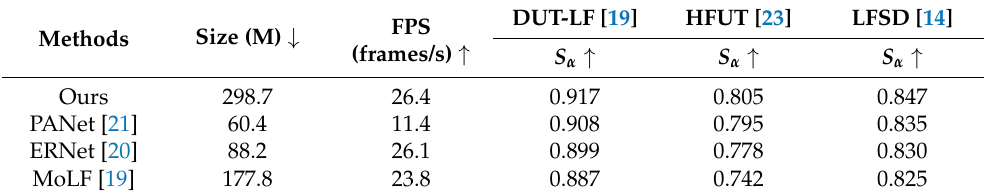
Table 3. Comparison of model